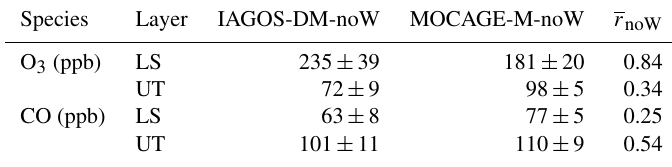
Table 4. As in Table 3 for IAGOS-DM and MOCAGE-M derived without weighting (IAGOS-DM-noW and MOCAGE-M-noW). Species